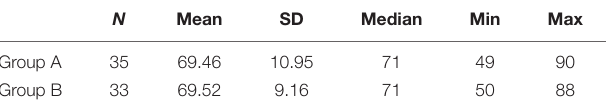
TABLE 5 | Comparisons between two groups in learning